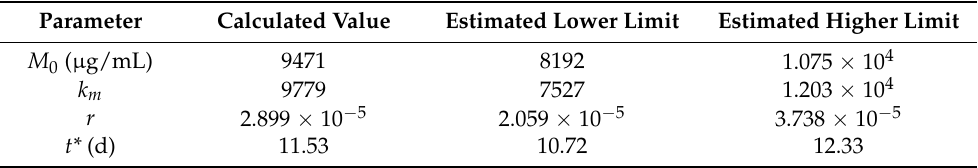
Table 1. The parameter estimation based on 95% confidence intervals (CIs) for the maximum chlorophyll-a (Chl-a) concentration.